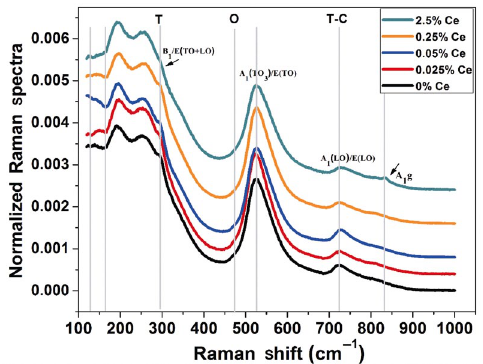
Fig. 3 Raman spectra of Ce-doped BCZT samples measured in ambient